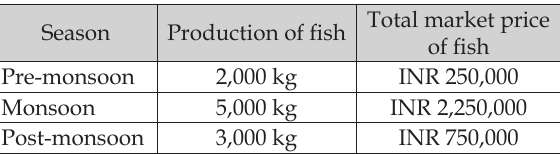
Table 7. Valuation of the market price of fish produc - tion in Suraha Tal Wetland in